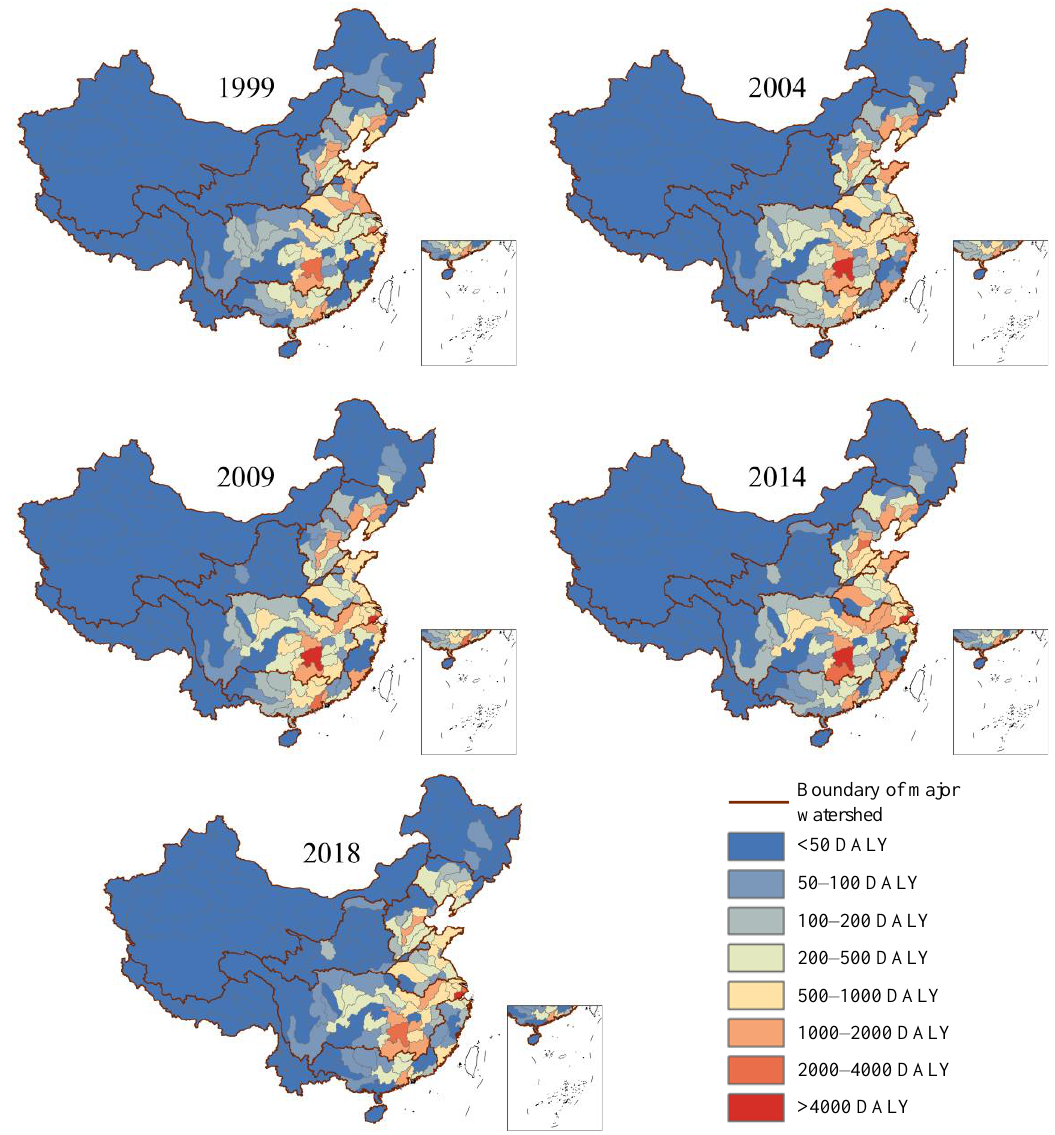
Figure 5. Distribution of DL caused by five heavy metal emissions in industrial wastewater. From 2004 to 2014, the EHR-IHM in the middle and lower reaches of the Yangtze River and southeast coastal areas gradually increased, especially in the Northwest River Delta and Huangpu River watersheds. For example, DL in Northwest River Delta increased to 3075.7 DALY in 2009, from 1782.4 DALY in 2004, while that in Huangpu River watershed increased from 877.1 DALY in 2004 to 1924.2 DALY in 2009 and 2109.4 DALY in 2014. These increases could be attributed to the accumulation of historical heavy metal emis- sions and streamflow migration from upstream to downstream watersheds. Meanwhile, the DL in the Haihe River watershed, the Minnan River watershed, and the upstream watershed of Xiangjiang River were all increased in this period, mainly due to heavy metals